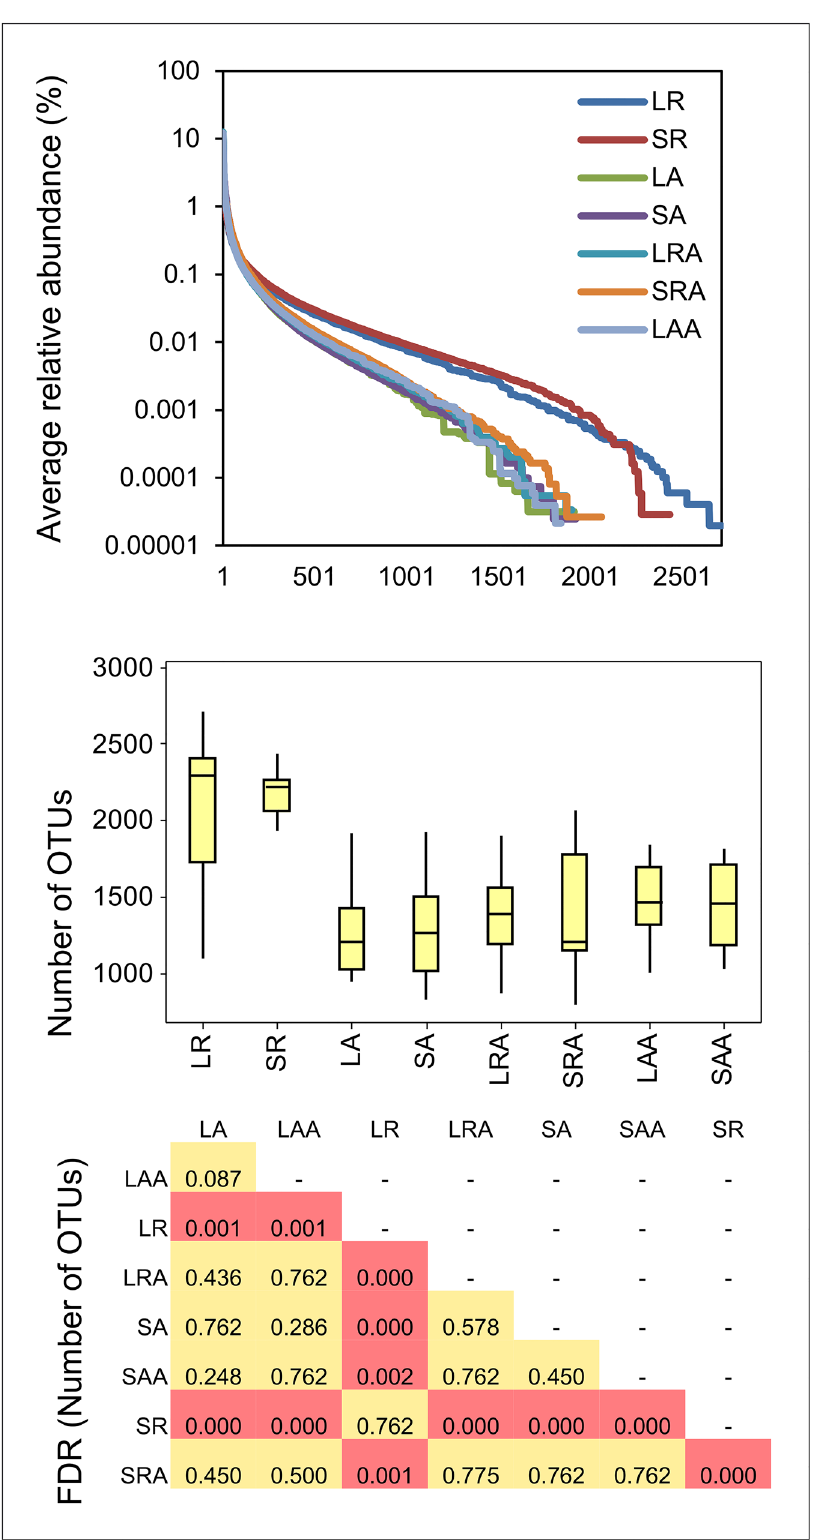
Fig 3. Difference between diversity of OTUs in rumens of restricted and ad libitum treatment groups LR = Liquid Restricted (n = 14), SR = Solid Restricted (n = 14), LA = Liquid Ad lib (n = 13), SA = Solid Ad lib